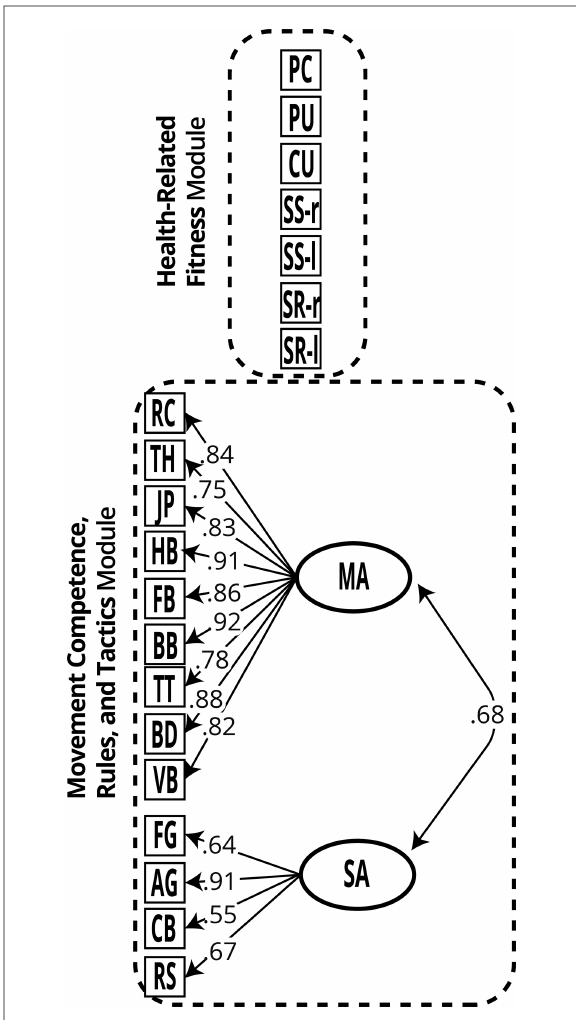
FIGURE 1 Portuguese Physical Literacy Assessment - Observation (PPLA-O) two modules, with estimated parameters for the movement competence, rules, and tactics module (2-dimensional graded response model). Legend: PC, Pacer; PU, Push-ups; CU, Curl-ups; SS-r, Shoulder Stretch (right); SS-l, Shoulder Stretch (left); SR-r, Backsaver Sit and Reach (right); SR-l, Backsaver Sit and Reach (left); RC, Races (athletics); TH, Throws (athletics); JP, Jumps (athletics); HB, Handball; FB, Football; BB, Basketball; TT, Table Tennis; BD, Badminton; VB, Volleyball; FG, Floor Gymnastics; AG, Artistic Gymnastics; CB, Climbing; RS, Rollerskating; MA, Manipulative- based Activities; SA, Stability-based